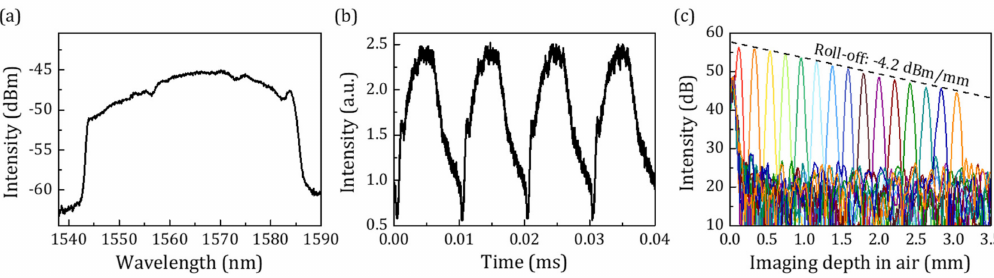
Figure 5. ( a ) Wavelength sweeping spectra on peak-hold mode. ( b ) Temporal shape of the sweeping spectra at a sweeping rate of 100 kHz. ( c ) Point spread function at di ff erent imaging